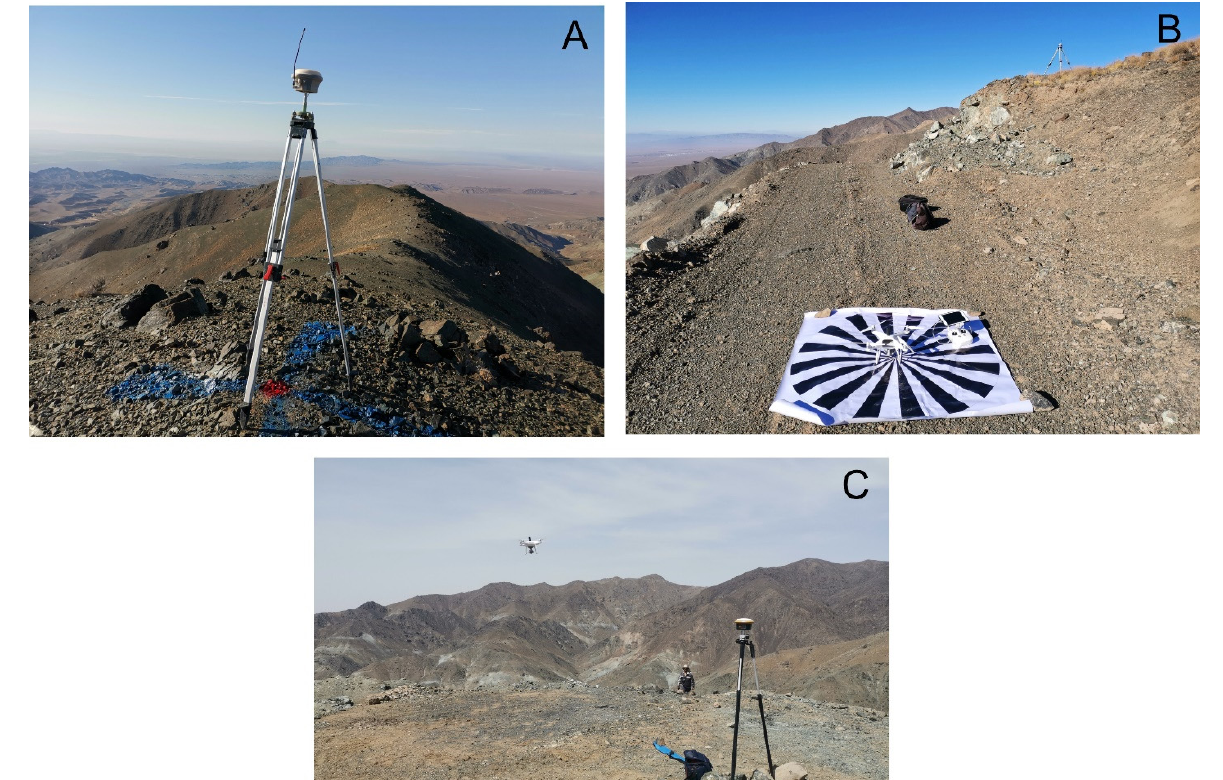
Figure 4. Example images of GNSS surveying and UAV flight missions. ( A ) Establishment of GNSS base station in one of the designed GCPs. ( B ) Preparing for a flight mission, below the drone, is the Siemens target used for spatial resolution control of images, the base station is located at the top high ground to use for PPK. ( C ) Finishing a flight mission by the method of direct georeferencing (using the on-board GNSS module with in situ ground support).